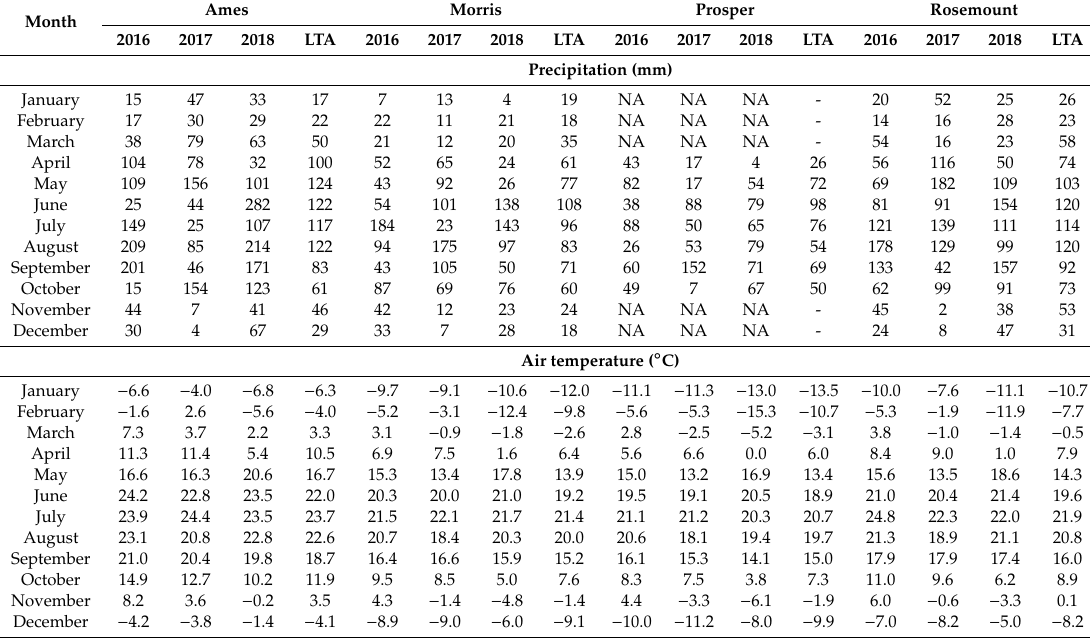
Table 1. Monthly total precipitation (mm) and monthly mean air temperature ( ◦ C) from January to December from 2016 to 2018 and long-term average (LTA) for the last 30 years at Ames (Iowa), Morris and Rosemount (Minnesota), and Prosper (North Dakota). Precipitation data for Prosper from November to March are missing. Weather data collected from nearby weather stations. Ames Morris Prosper